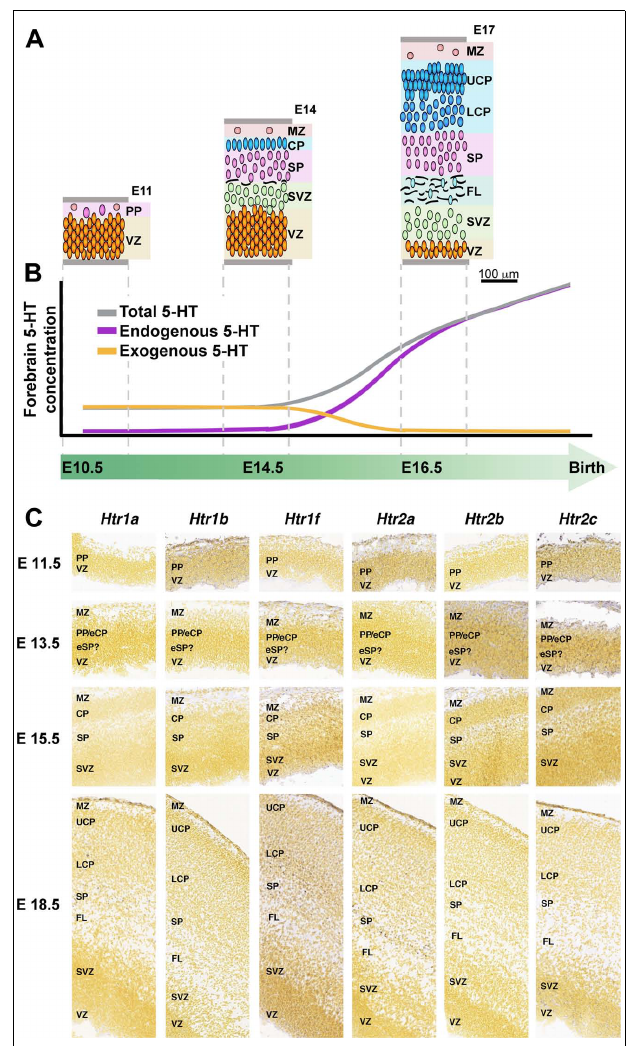
FIGURE 4 | 5-HT and 5-HT receptors in mouse developing cerebral cortex. (A) Organization of the developing mouse cortex at E11, E14, and E17, modified from Smart etal. (2002) with permission. (B) Dynamic of 5-HT brain sources during intrauterine development, early exogenous (placenta; orange line) switch to a latter endogenous (5-HT brainstem axons, purple line) 5-HT source, modified from Bonnin etal. (2011), with permission. (C) Expression of 5-HT receptors during mouse cortical development, ISH obtained from Allen Developing Mouse Brain Atlas, available from: http://developingmouse.brain-map.org. CP, cortical plate; eCP, early cortical plate; eSP, early subplate; FL, fiber layer; LCP, lower cortical plate; MZ, marginal zone; PP, preplate; SP, subplate; SVZ, subventricular zone;VZ, ventricular zone; UCP, upper cortical